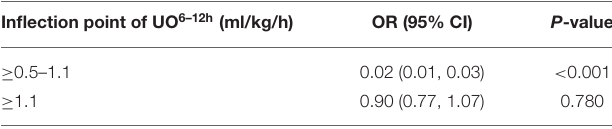
TABLE 3 | Threshold effect analysis of UO 6 − 12h and progression to stage 2/3 AKI by UO using piecewise linear regression. Inflection point of UO 6–12h